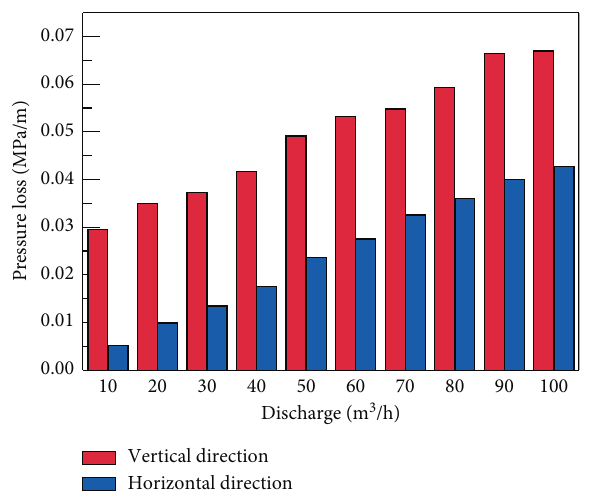
Figure 5: The pressure loss comparison between the vertical and horizontal pipes under different